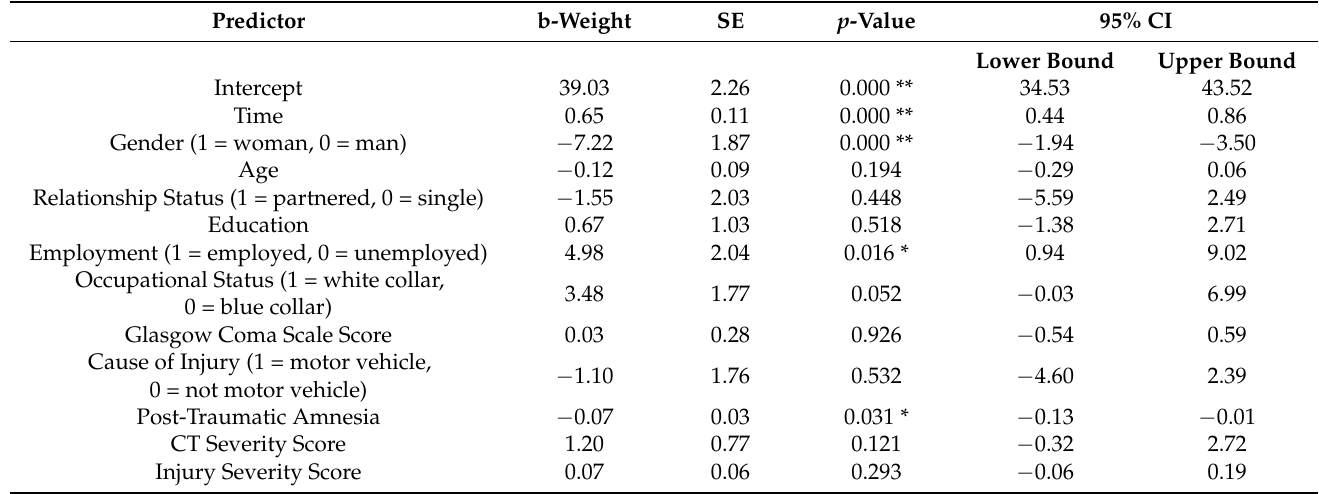
Table 3. Socio-demographic and injury predictors of the physical health (PCS) trajectories across 1, 2, 5, and 10 years.